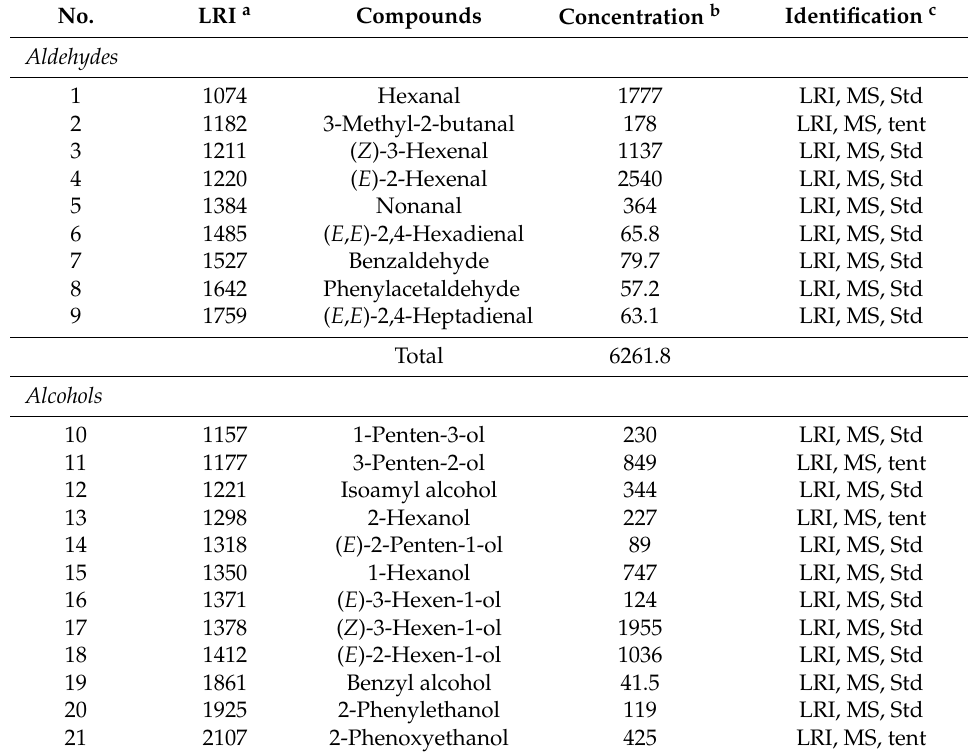
Table 2. Volatile composition of cv. Ayvalik extra virgin olive